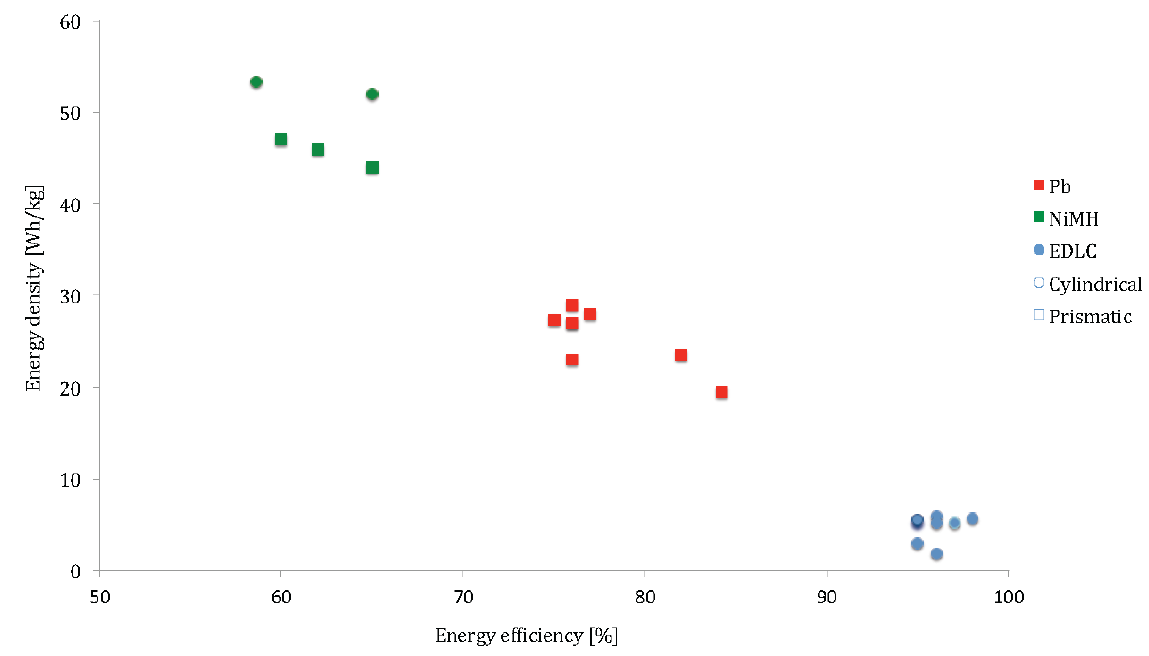
Figure 8. Energy density versus energy efficiency of nickel based, lead-acid batteries and EDLCs on cell